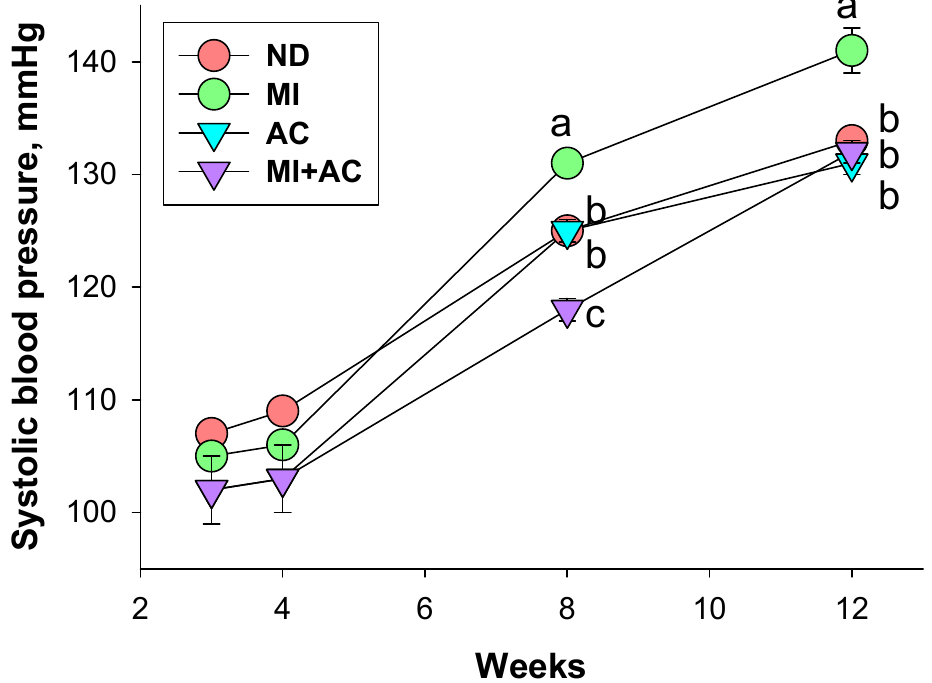
Figure 1. Effect of minocycline administration (MI) and acetate supplementation (AC) on systolic blood pressure in offspring from 3 to 12 weeks of age ( n = 7–8/group). The letters a, b, and c denote significant differences between groups ( p < 0.05, two-way ANOVA). ND = rats received vehicle (control); MI = rats received minocycline; AC = rats received acetate; MI + AC = rats received minocycline and acetate